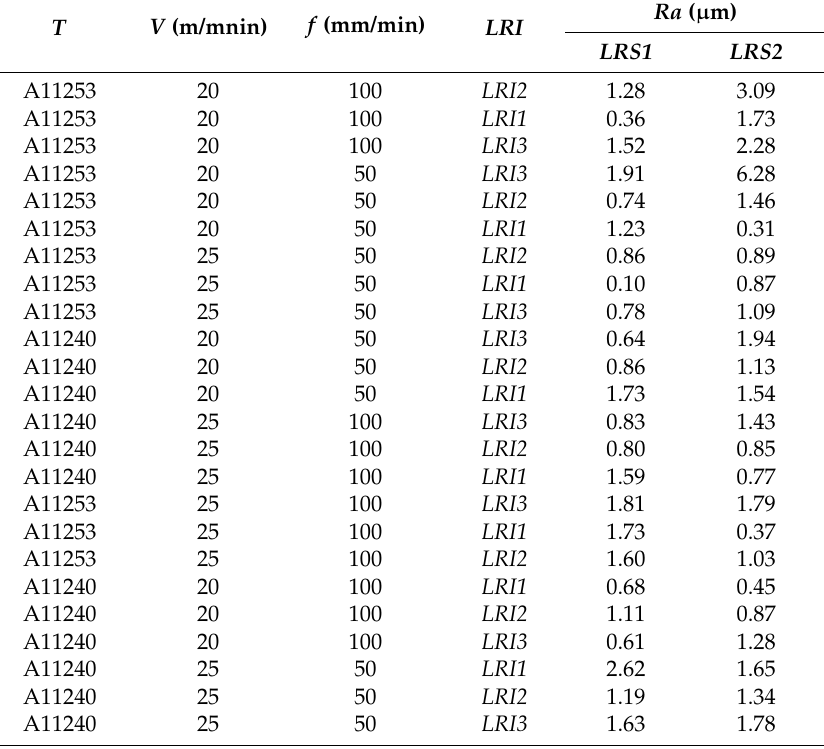
Table 5. Roughness average Ra ( µ m) obtained during the experiments.